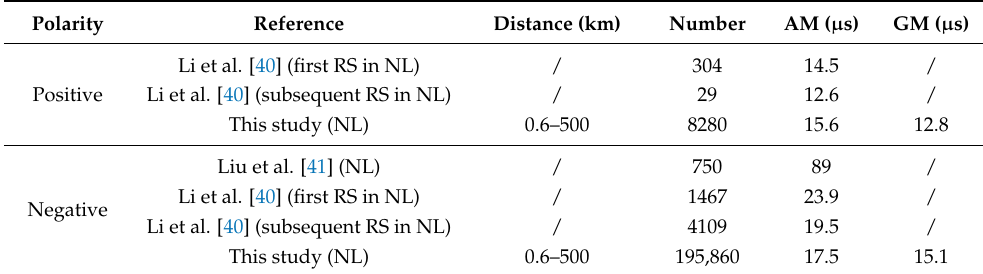
Table 3. Comparison of fall time among different